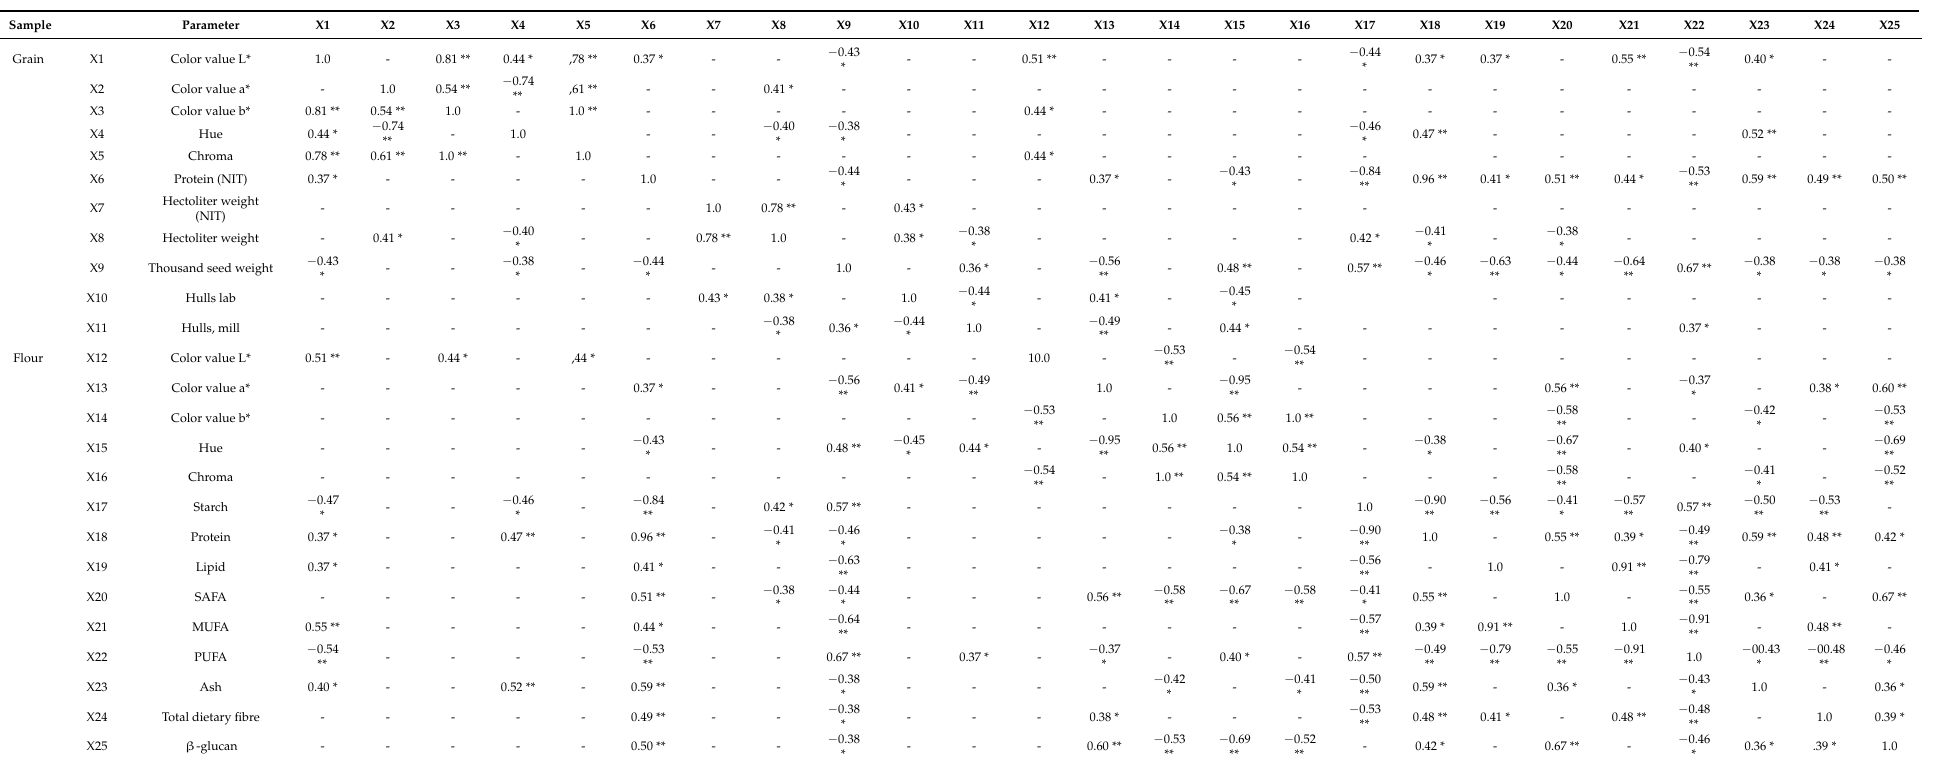
Table A7. Pearson correlation coefficients of 30 native oat grain and industrially produced oat flour properties. The color values are L*, a* and b*. NIT, near-infrared transmittance; SAFA, saturated fatty acids; MUFA, monounsaturated fatty acids; PUFA, polyunsaturated fatty acids.